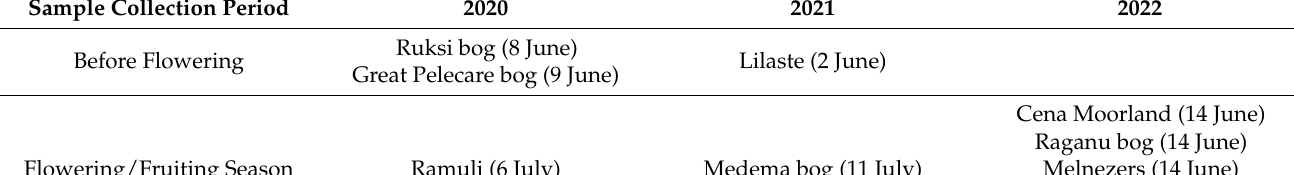
Table 6. Date of sample-gathering and corresponding period of the vegetation season during field survey of wild cloudberry stands in Latvia.